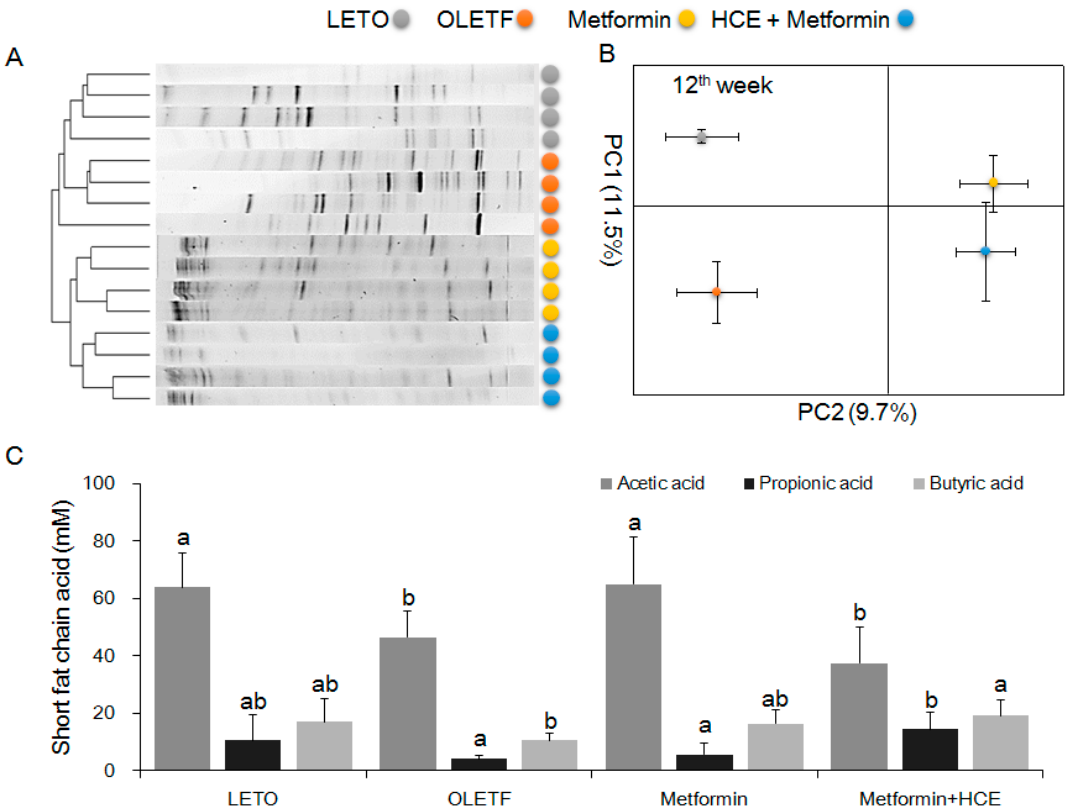
Figure 7. Impact of metformin either alone or in combination with HCE on the gut microbial population and the abundance of short chain fatty acids in the stool of OLETF rats. ( A ) The microbial communities in the fecal samples were analyzed by PCR-denaturing gradient gel electrophoresis (DGGE) as described in the Materials and Methods section; ( B ) Principal component analysis (PCA) of the data was performed based on distance matrix (two-dimensional array) for the evaluation of similarity between bacterial communities; ( C ) The levels of fecal acetic acid, propionic acid, and butyric acid are shown. Data with different letters are significantly different ( p < 0.05) according to one way ANOVA analysis.